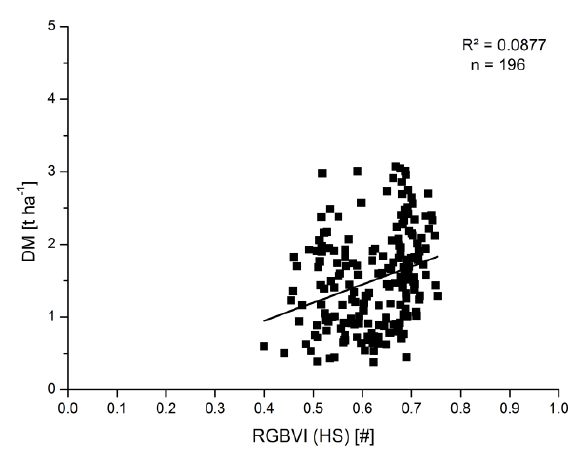
Figure 6b. RGBVI from hyperspectral measurements versus dry matter (DM), G 2 & 3